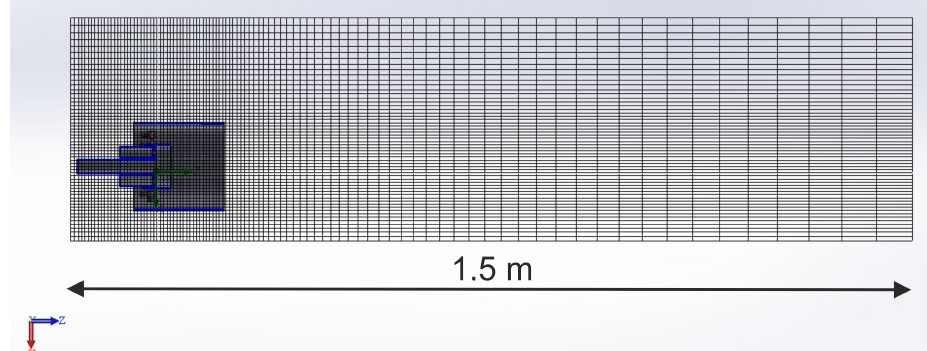
Figure 3. Three-dimensional model of a gas-thermal burner in a domain divided into cells.